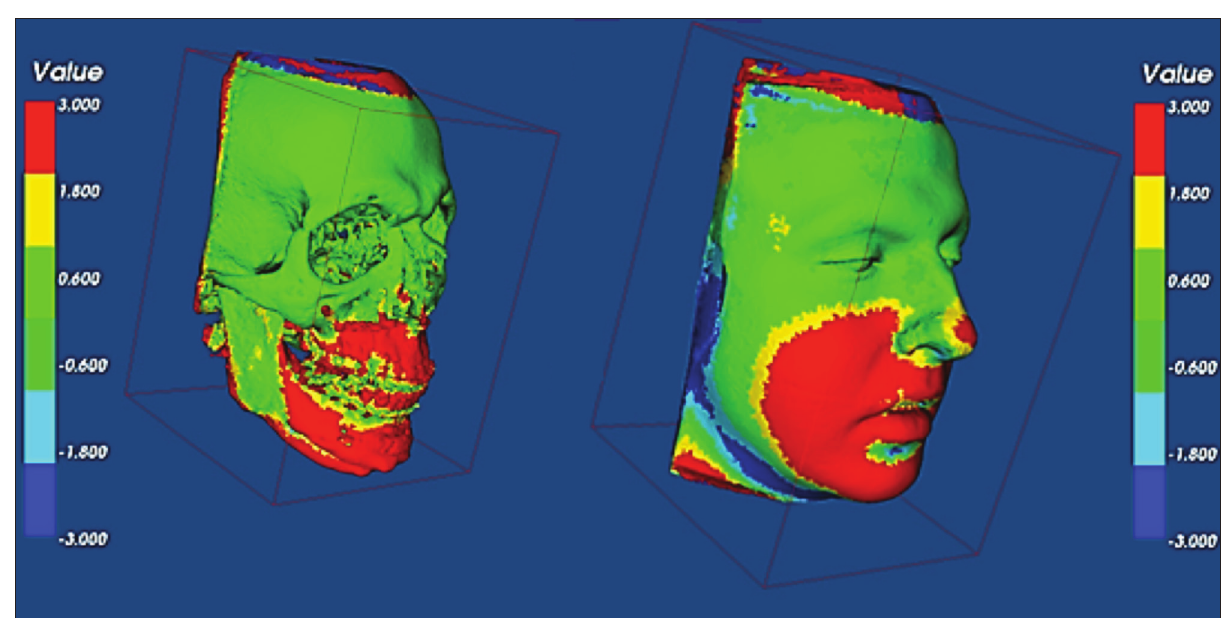
Figure 12. Colour-coded 3D superimposition of the pre- and post-surgery CBCT scans showing skeletal and soft tissue changes. Red indicates a change of